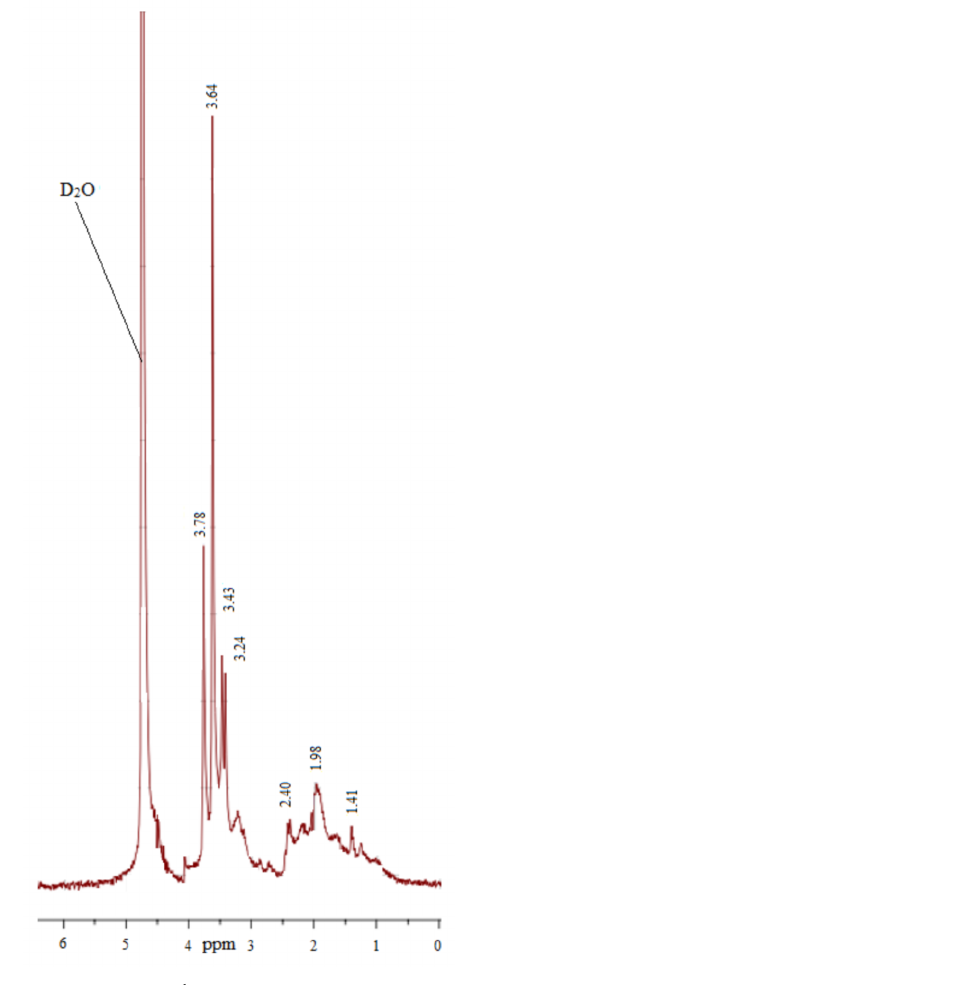
Figure 2. NMR 1 H spectrum in D 2 O medium registered for a copolymer obtained at a molar ratio VP/GMA equal to 1.4.